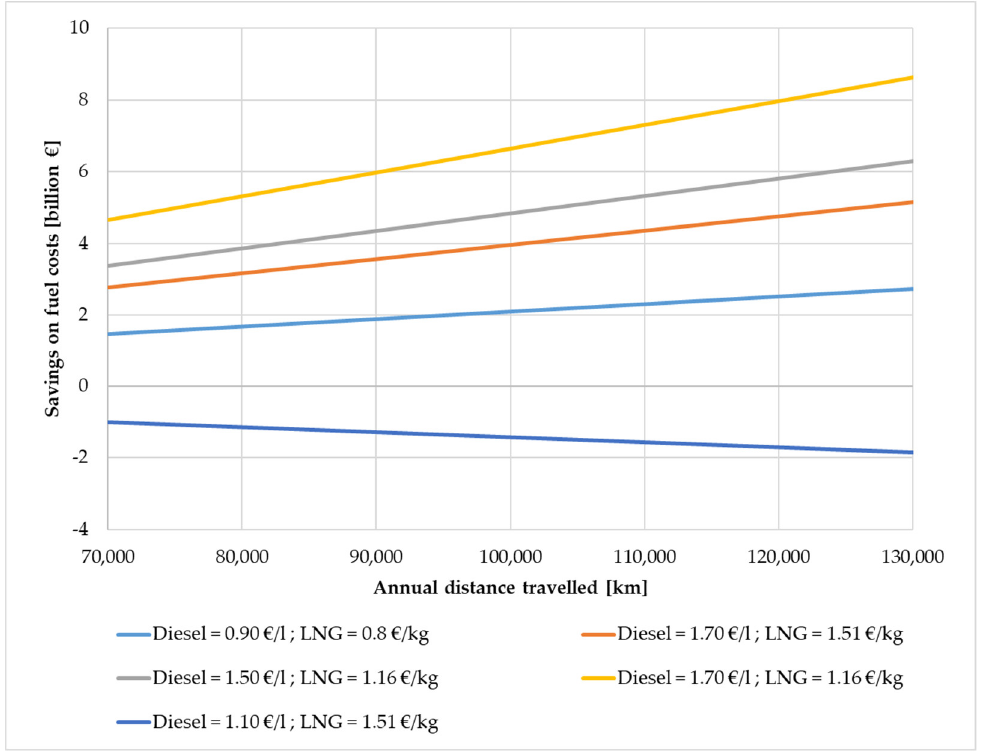
Figure 2. Saving on fuel costs for five different price scenarios on EU